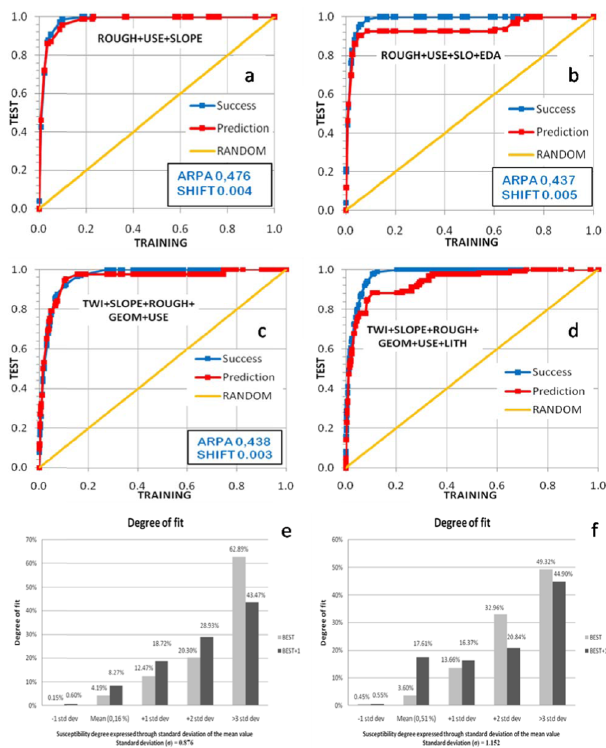
Fig. 6. Comparison of best and best +1 model. With validation curves fall best model (a) ; fall best+1 model (b) ; debris flows best model (c) ; debris flows best+1 model (d) . Degree of fit between susceptibility range and falls (e) or debris flows (f)